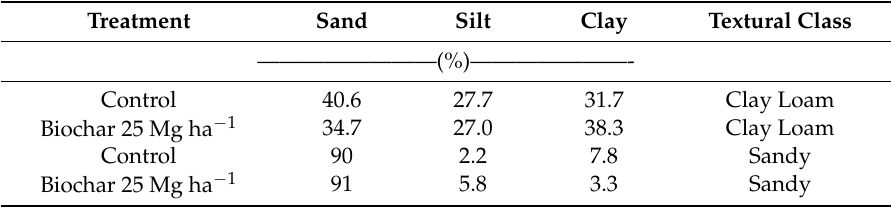
Table 2. Influence of biochar amount on soil texture in sandy and clay loam soil.